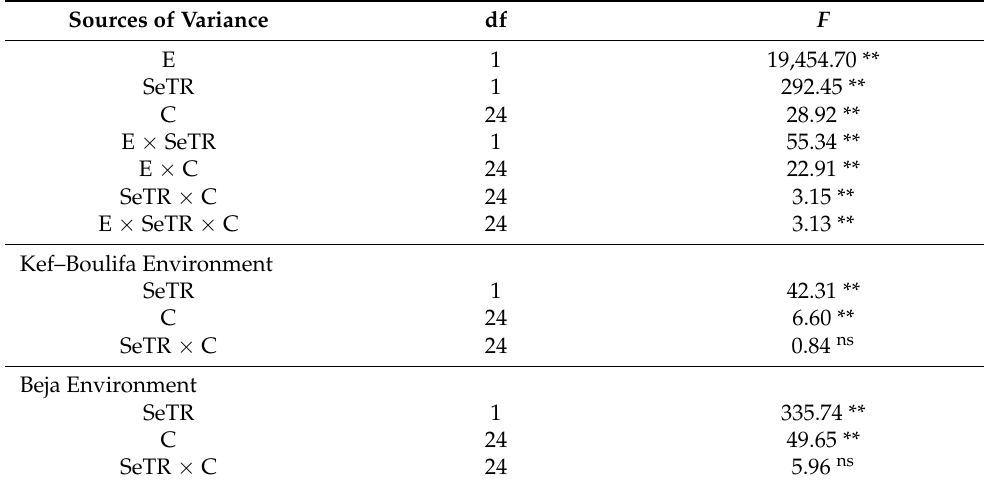
Table 1. Analysis of variance ( F values) for grain yield of 25 durum wheat cultivars across the two environments. Sources of Variance